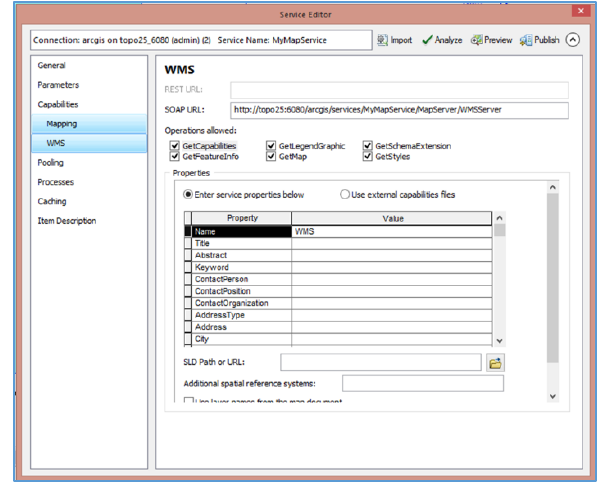
Figure 3. WMS service